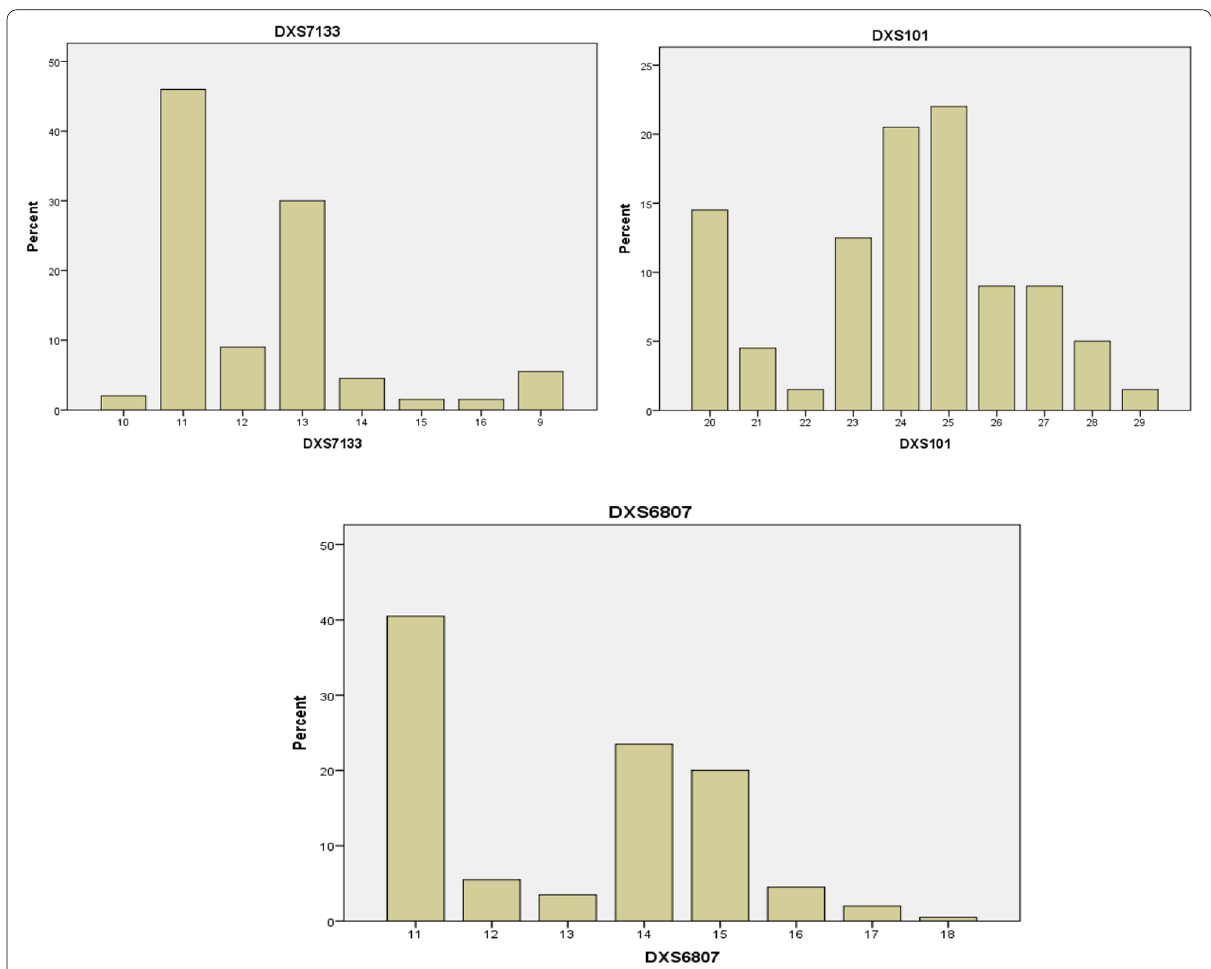
Fig. 5 The percent distribution of allele frequency of the fourth group (DXS7133 DXS101 and DXS6807)